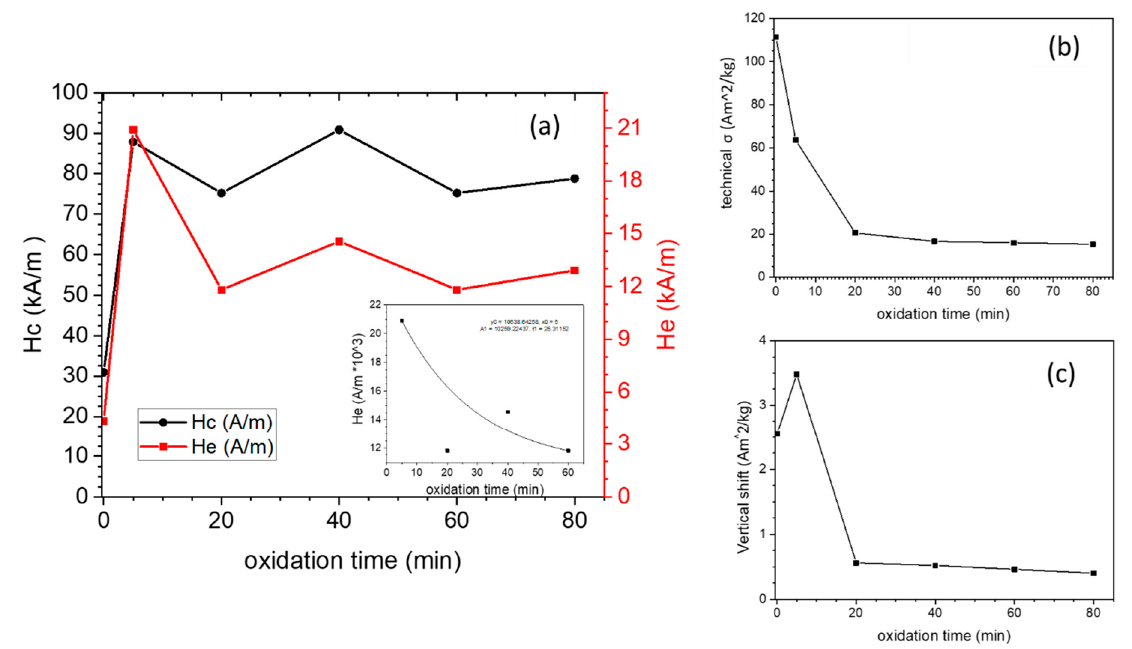
Figure 10. The effect of oxidation time on the magnetic properties of OMO-series. ( a ) Variation in the coercivity (H c ) and exchange bias (H e ), ( b ) variation in the technical saturation magnetization σ , and ( c ) variation in the vertical shift. The inset shows the fitted curve of the decrease in exchange bias with increasing oxidation time.